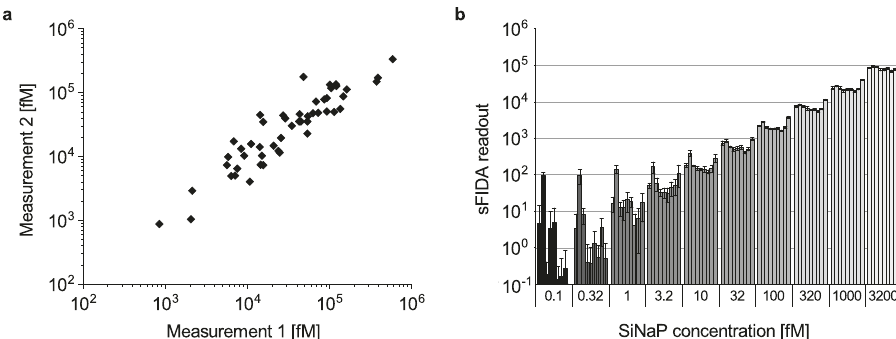
Fig. 3 Repeated measurements of α -synuclein aggregates in stool and of α -synuclein SiNaPs yield highly replicable results. We tested the inter-assay variance of the sFIDA assay for α -synuclein aggregates. a Repeated measurements of 50 randomly selected stool samples by the same operator in the same laboratory on different days were highly reproducible with a Spearman coef fi cient of correlation of r = 0.916 ( p = 0.2 × 10 − 6 ). b Nine independent measurements of a dilution series of the α -synuclein SiNaPs used for calibration of the stool sample data set also showed highly replicable results for all concentrations with a Spearman coef fi cient of correlation of r = 0.979 ( p = 3.85 × 10 − 62 ). Error bars indicate standard